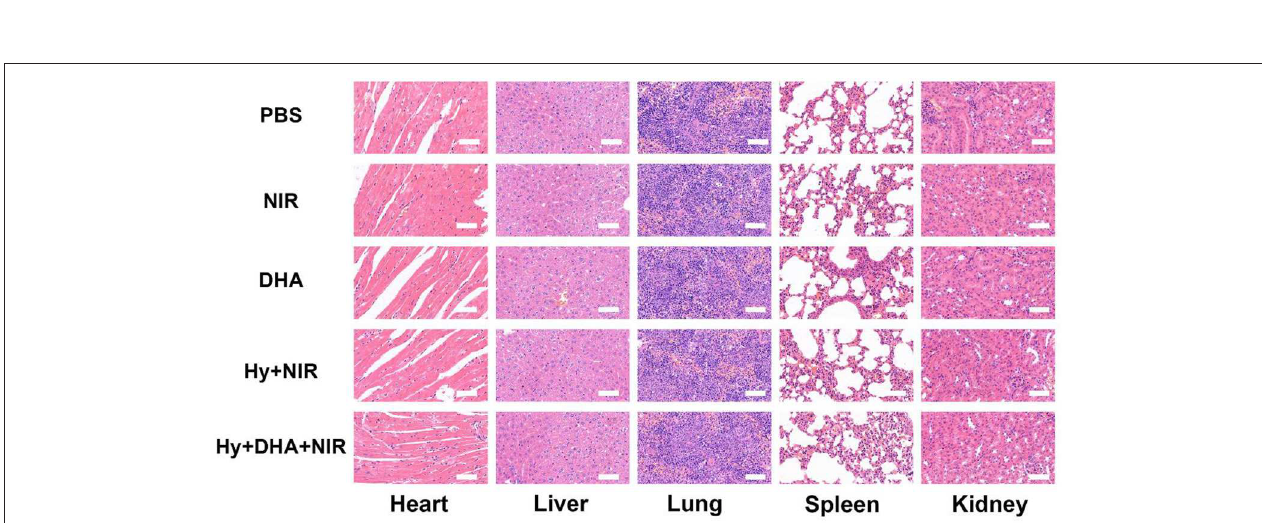
Frontiers in Chemistry | www.frontiersin.org